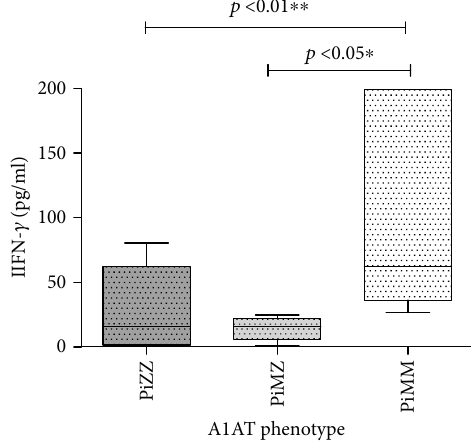
Figure 2: Comparison of IFN- γ levels in COPD patients with PiZZ, PiMZ, and PiMM phenotypes of